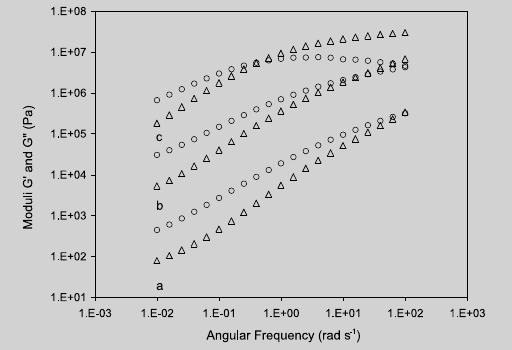
Figure 3 (left): Spectromechanical results (G’ ( D ); G” ( o )) for molasses/lime/water